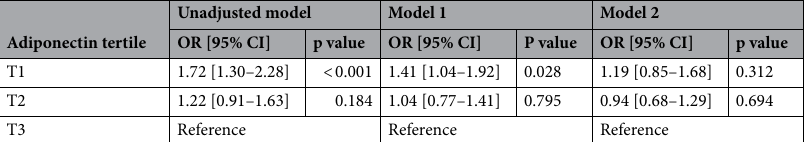
Table 3. Multivariate analysis of the association between serum adiponectin tertile and high mental component summary (MCS). Model 1: Adjusted for age, sex, body mass index, marriage, economy, education, systolic blood pressure, diabetes, dyslipidemia, cardiovascular disease, estimated glomerular filtration rate, urine protein to creatinine ratio, C-reactive protein, hemoglobin, and albumin. Model 2: Adjusted for Model 1 + current smoking, alcohol, and physical